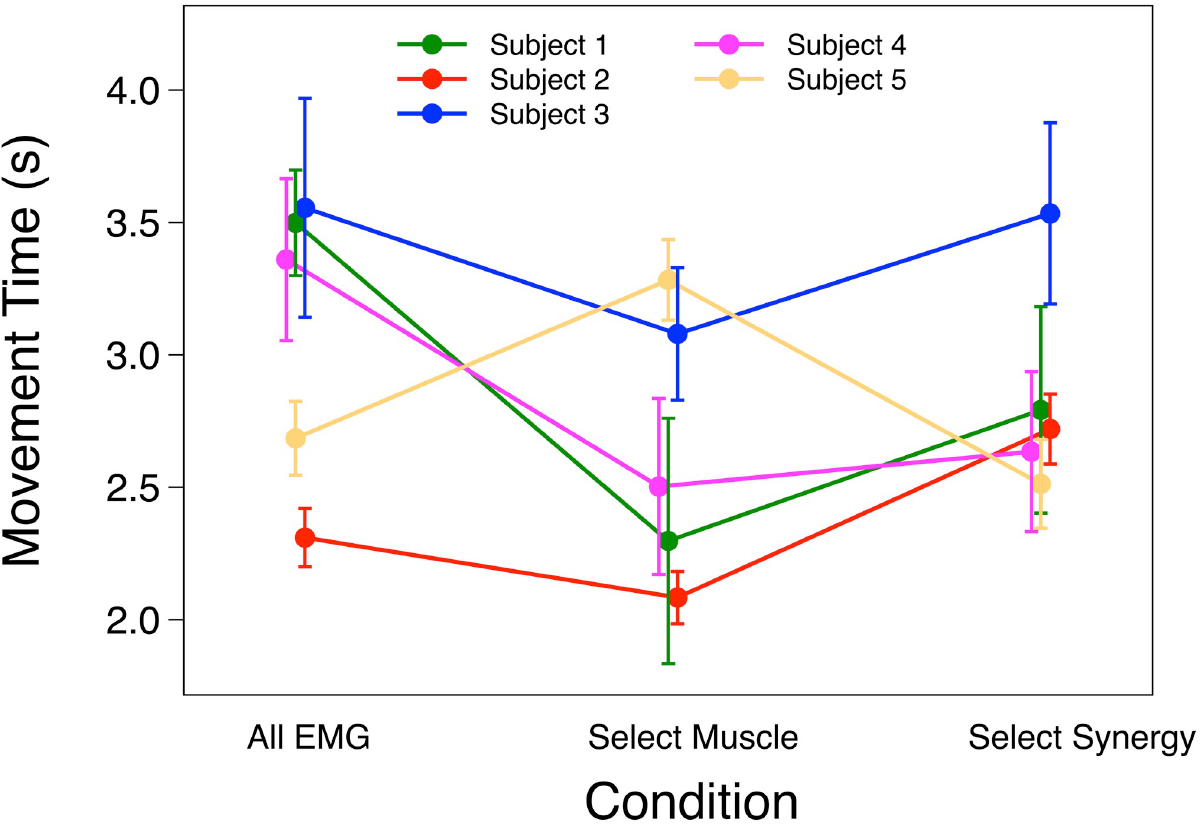
Fig 4. Movement time. Mean and SEM of movement time (MT) of each participant using All EMG, Select Muscle, and Select Synergy control.